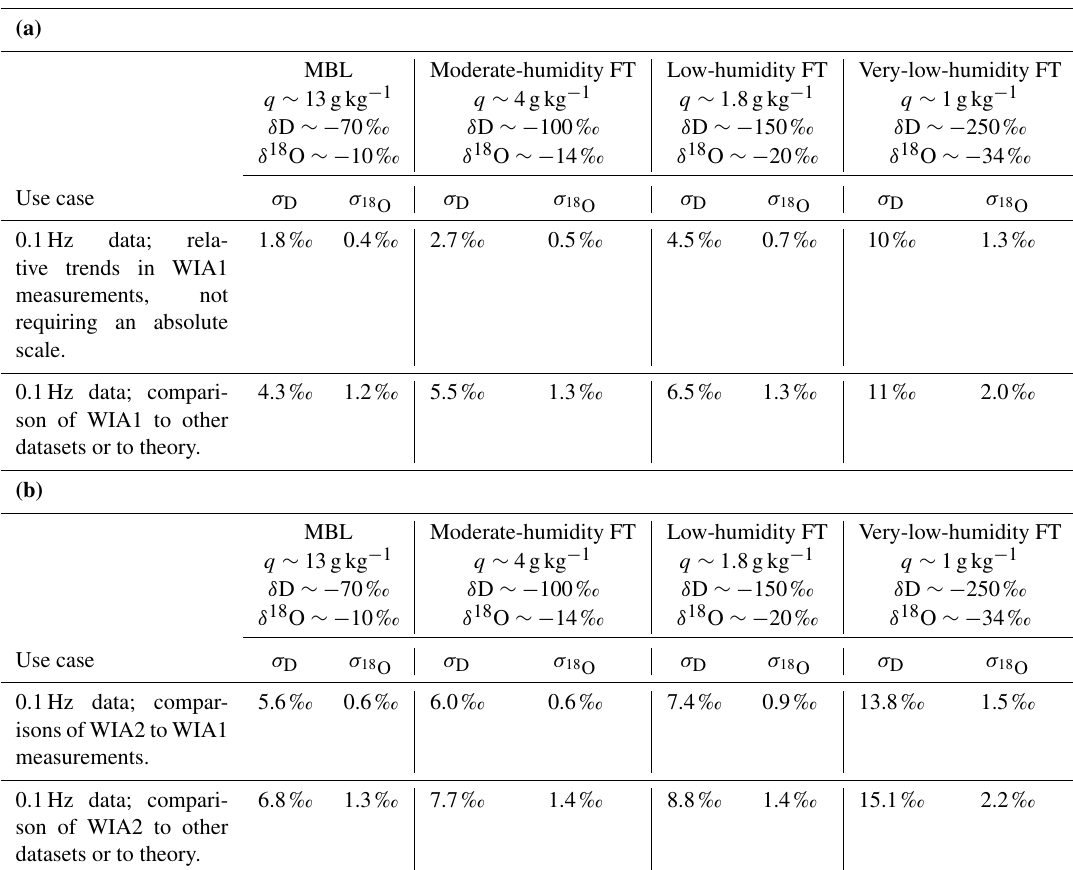
Table 4. (a) Characteristic WIA1 isotope ratio errors (e.g., ± 2 σ gives 95% confidence intervals) for four typical situations observed in ORACLES. These include MBL sampling and free troposphere (FT) sampling at a few humidities (the q and δ values under each header are typical values observed in that situation). Additionally, values for two separate use cases are included: studies looking at relative trends in the ORACLES WISPER dataset vs. comparison of this dataset to others or to theory. (b) Same as panel (a) but for WIA2